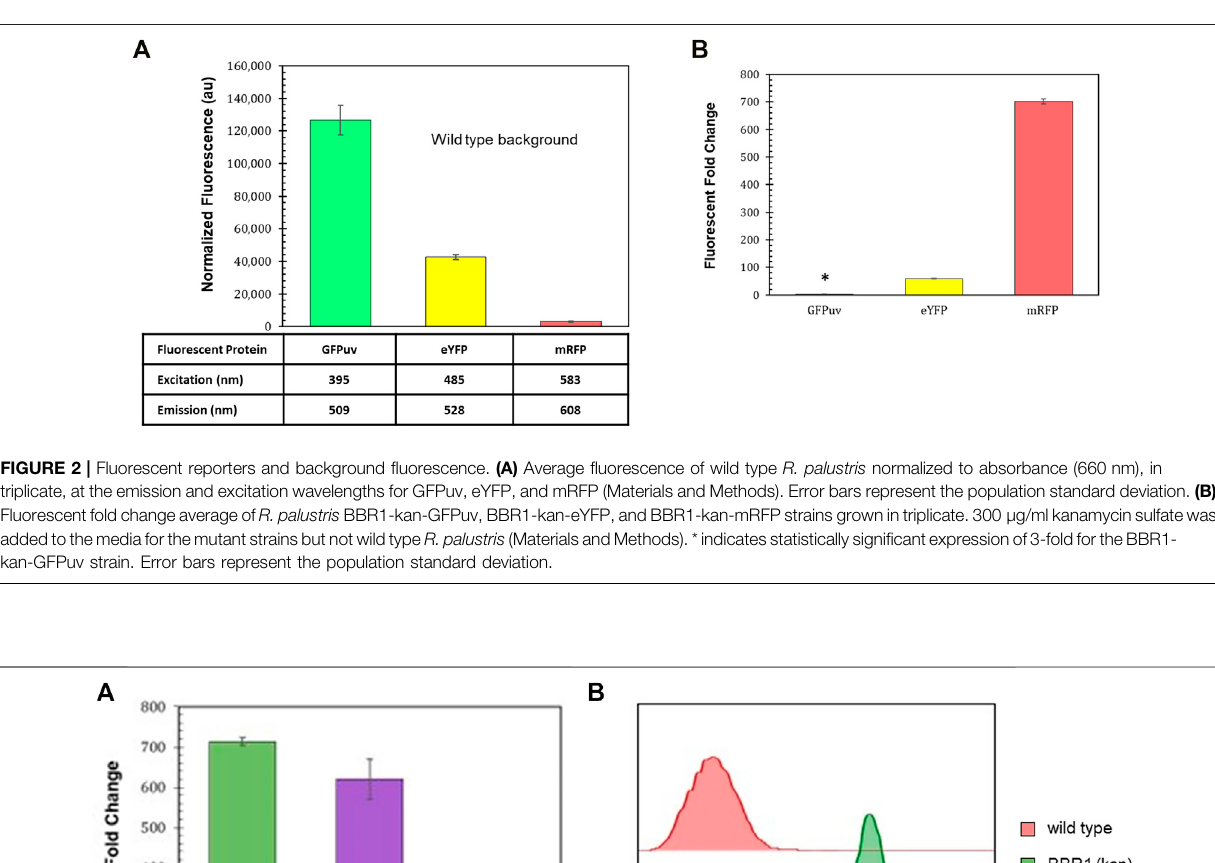
The growth procedure, media, and antibiotics are the same as for the fl uorescent fold change test in Figure 3A (Materials and Methods).